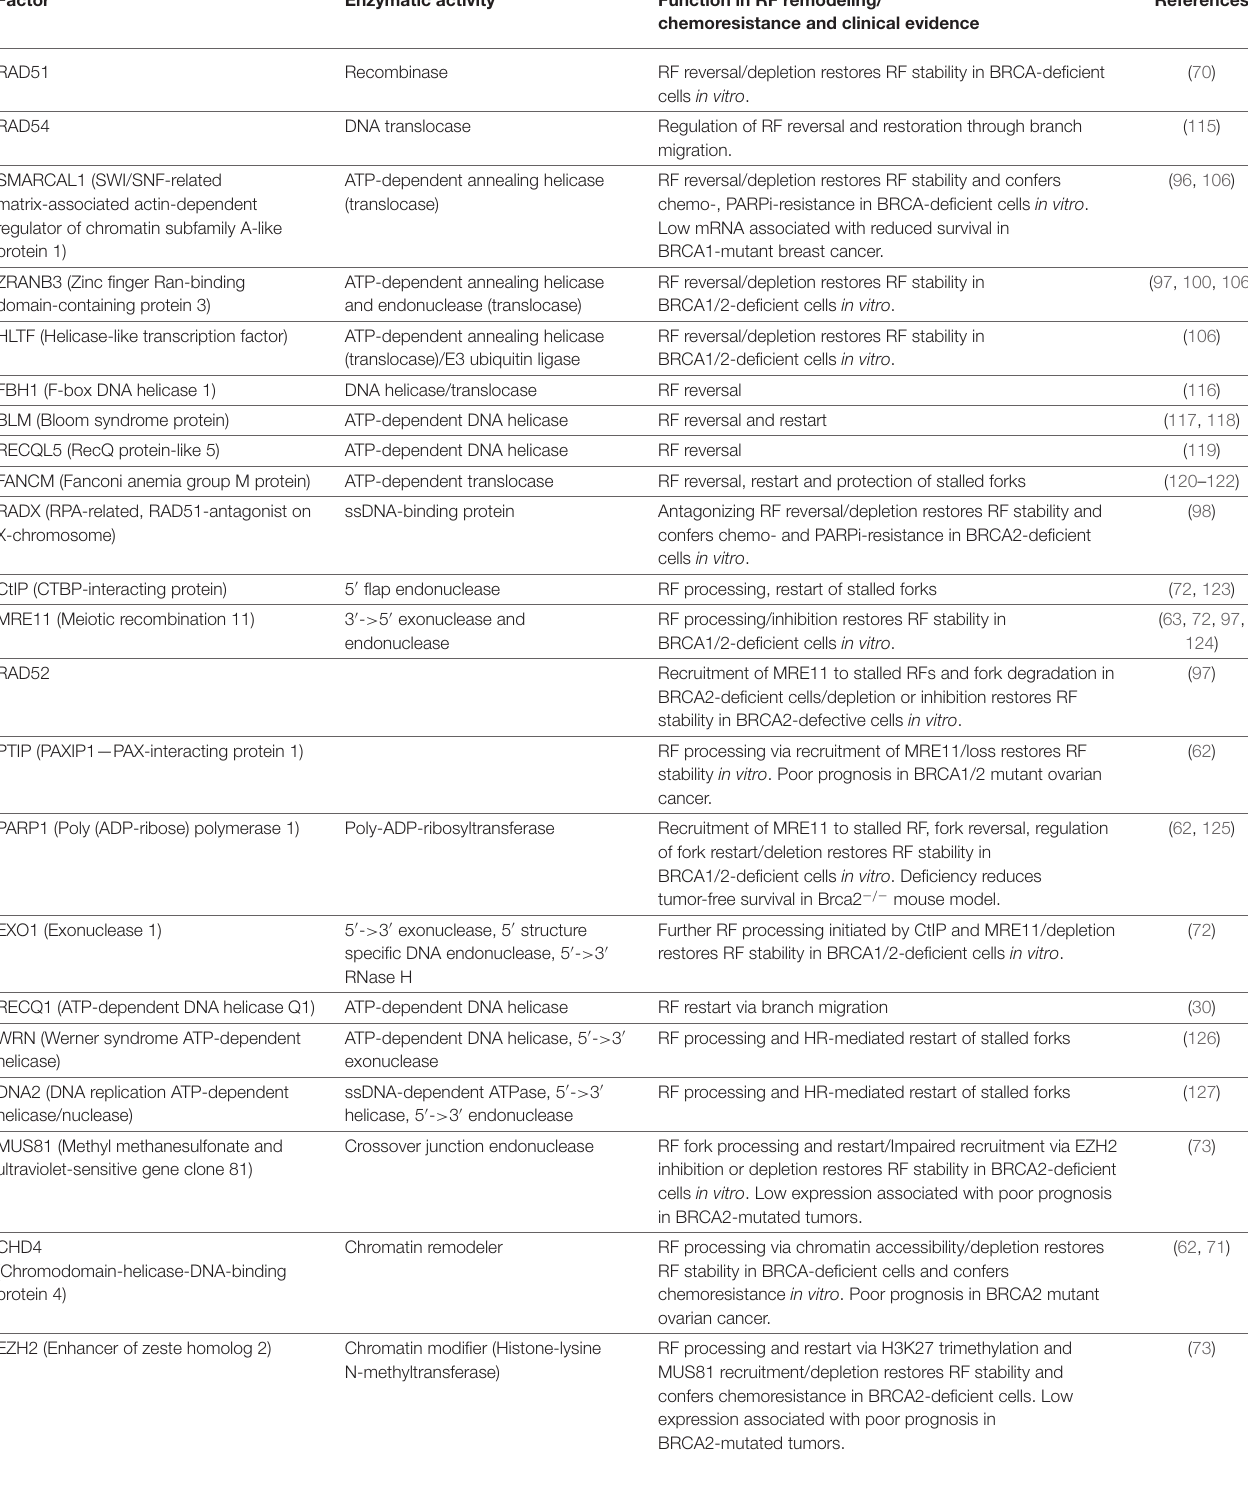
TABLE 2 | Overview of several key players involved in RF